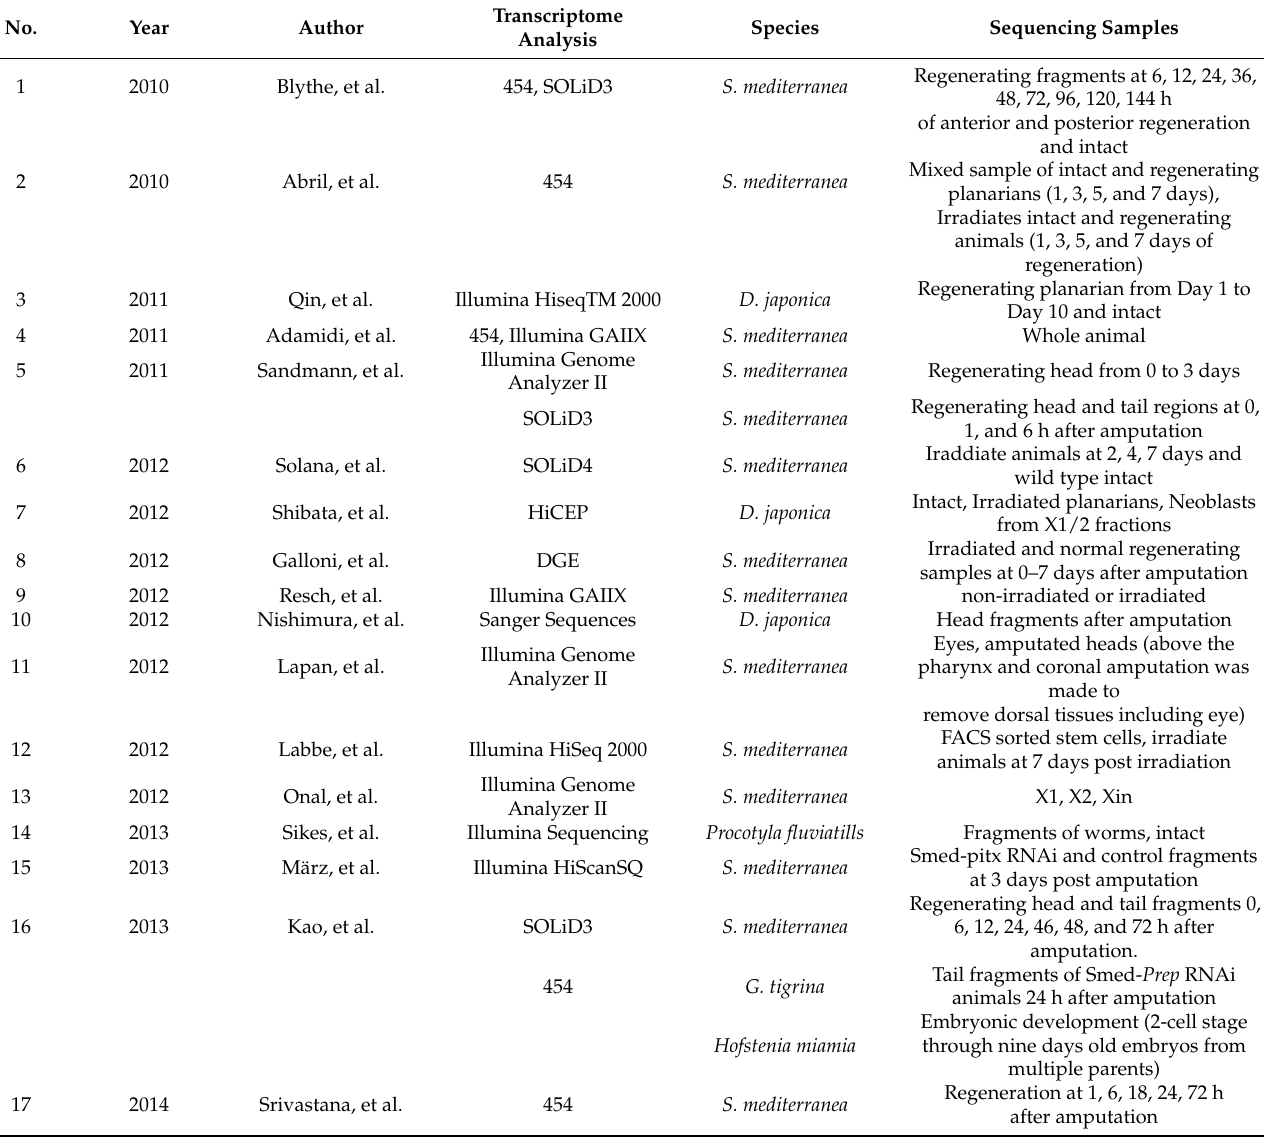
Table 1. Peer-reviewed articles presenting planarian transcriptome